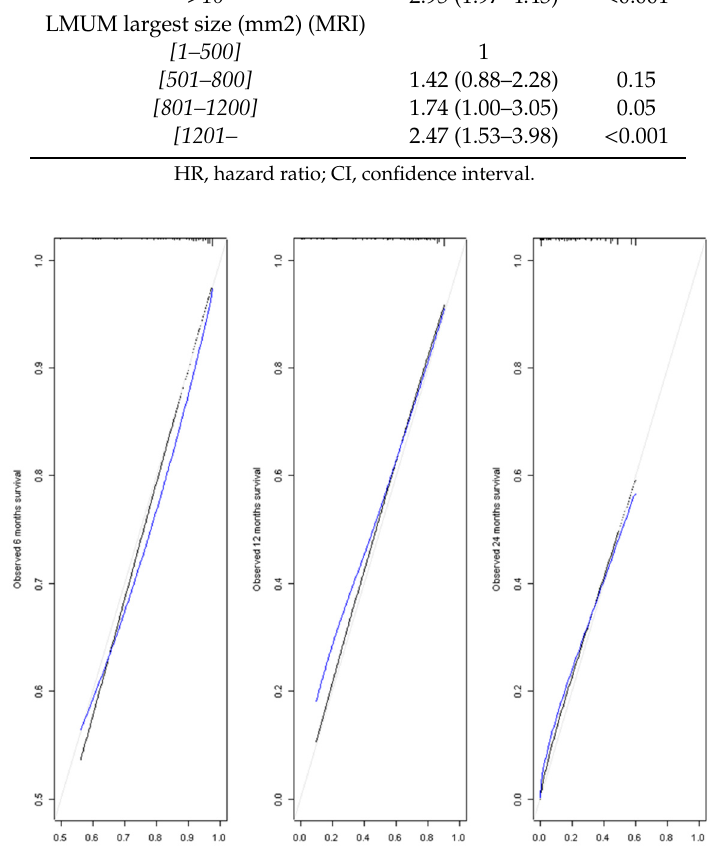
Figure 2. Calibration curves at 6, 12, and 24 months. Estimate of calibration accuracy was performed using adaptive spline regression. The line adjacent to the ideal line corresponds to the apparent predictive accuracy. The blue line corresponds to corrected estimates.